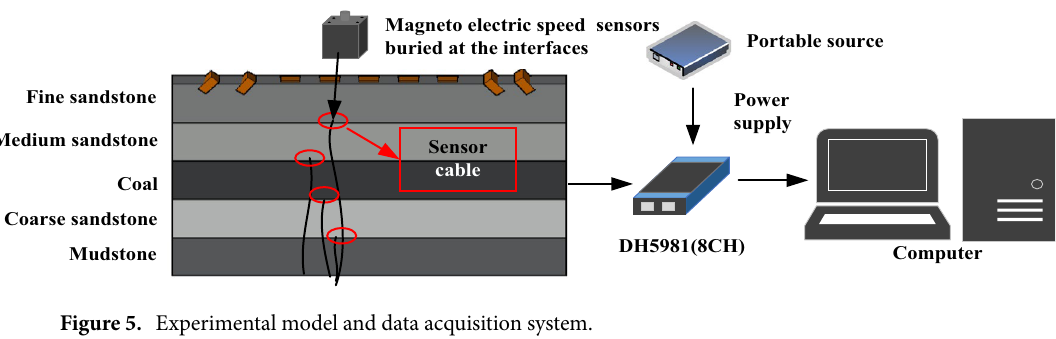
Figure 5. Experimental model and data acquisition